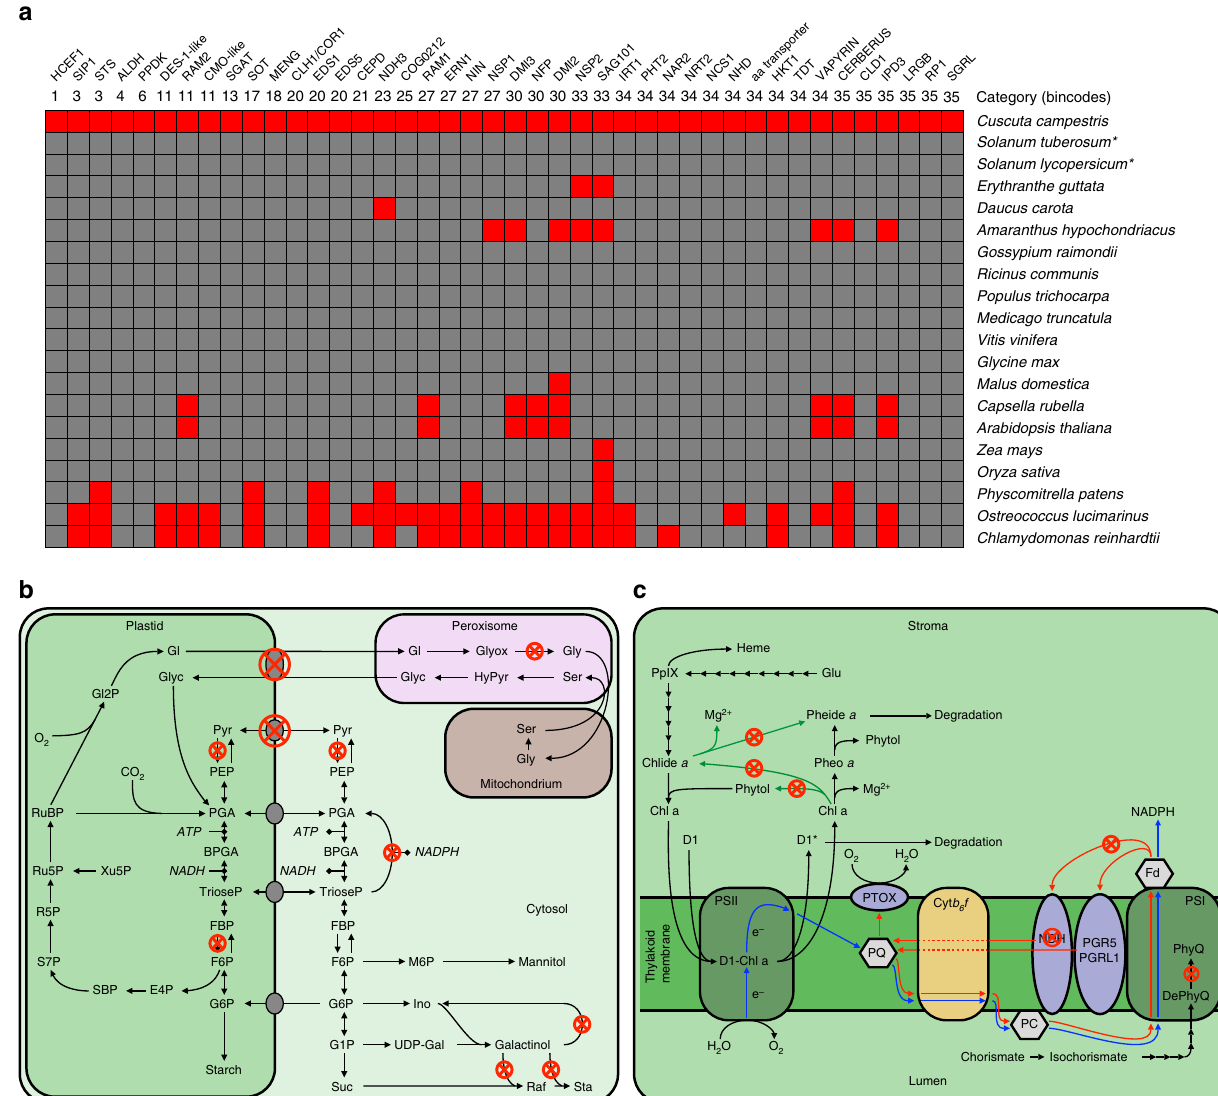
Fig. 4 Comparison of gene losses between C. campestris and autotrophic plants. a Presence (gray) and absence (red) of 42 lost genes connected to photosynthesis, metabolism, transport processes, and symbiotic interactions in 19 sequenced genomes (from Phytozome v.12.0) of the angiosperms, lower plants, and green algae. Species names are shown on the right in the order of increasing evolutionary distance from C. campestris (from top to bottom). Gene abbreviations and MapMan bincodes are given on the top. Full gene names and descriptions of the bincodes are given in Supplementary Table 5. Asterisks behind species names indicate that the sequences from these species were used as query for manual homology searches against the C. campestris genome. b Schematic view of primary carbon metabolism, i.e., Calvin cycle, photorespiration, plastid and cytosolic glycolysis and gluconeogenesis, and synthesis of the compatible solutes mannitol, raf fi nose and stachyose. Enzymatic reactions for which genes are missing are indicated by circled red crosses. E4P erythrose-4-phosphate, F6P fructose-6-phosphate, FBP fructose-1,6-bisphosphate, G1P glucose-1-phosphate, G6P glucose-6- phosphate, Glyc glycerate, Gly glycine, Gl glycolate, Gl2P glycolate-2-phosphate, Glyox glyoxylate, HyPyr hydroxypyruvate, Ino inositol, M6P mannose-6- phosphate, PEP phosphoenolpyruvate, PGA 3-phosphoglycerate, BPGA 1,3-bisphosphoglycerate, Pyr pyruvate, Raf raf fi nose, R5P ribose-5-phosphate, Ru5P ribulose-5-phosphate, RuBP ribulose-1,5-bisphosphate, S7P sedulose-7-phosphate, SBP sedulose-1,7-bisphosphate, Ser serine, Sta stachyose, Suc sucrose, TrioseP triose phosphates, UDP-Gal UDP-galactose, Xu5P xylulose-5-phosphate. c Schematic view of photosynthetic electron transport, chlorophyll regeneration, and degradation pathways and phylloquinone synthesis. Enzymatic reactions for which genes are missing are indicated by circled red crosses. Chl a chlorophyll a, Chlide a Chlorophyllide a , Cyt b 6 f cytochrome b 6 f complex, D1 D1 protein of photosystem II, D1* damaged D1 protein, DePhyQ demethylphylloquinone, e − electron, Fd ferredoxin, Glu glutamate, NDH NADH-dehydrogenase complex, PC plastocyanin, PGR5/PGRL1 proton gradient regulation 5/PGR5-like photosynthetic phenotype 1-complex, Pheide a pheophorbide a , Pheo a pheophytin a , PhyQ phylloquinone, PpIX Protoporphyrin IX, PQ plastoquinone, PS I photosystem I, PS II photosystem II, PTOX plastid terminal